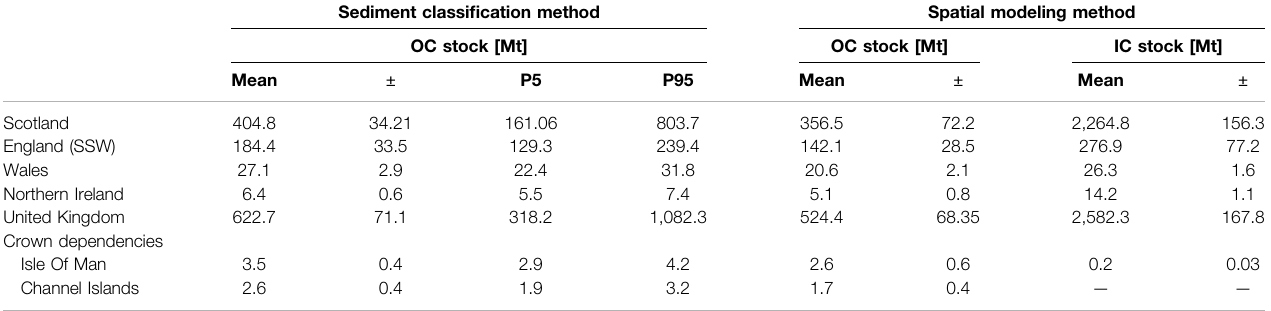
TABLE 2 | Sur fi cial sediment C stocks estimated using the sediment classi fi cation and spatial modeling methodologies. Data present as mean, standard deviation (1 σ ) and 5th and 95th percentiles.